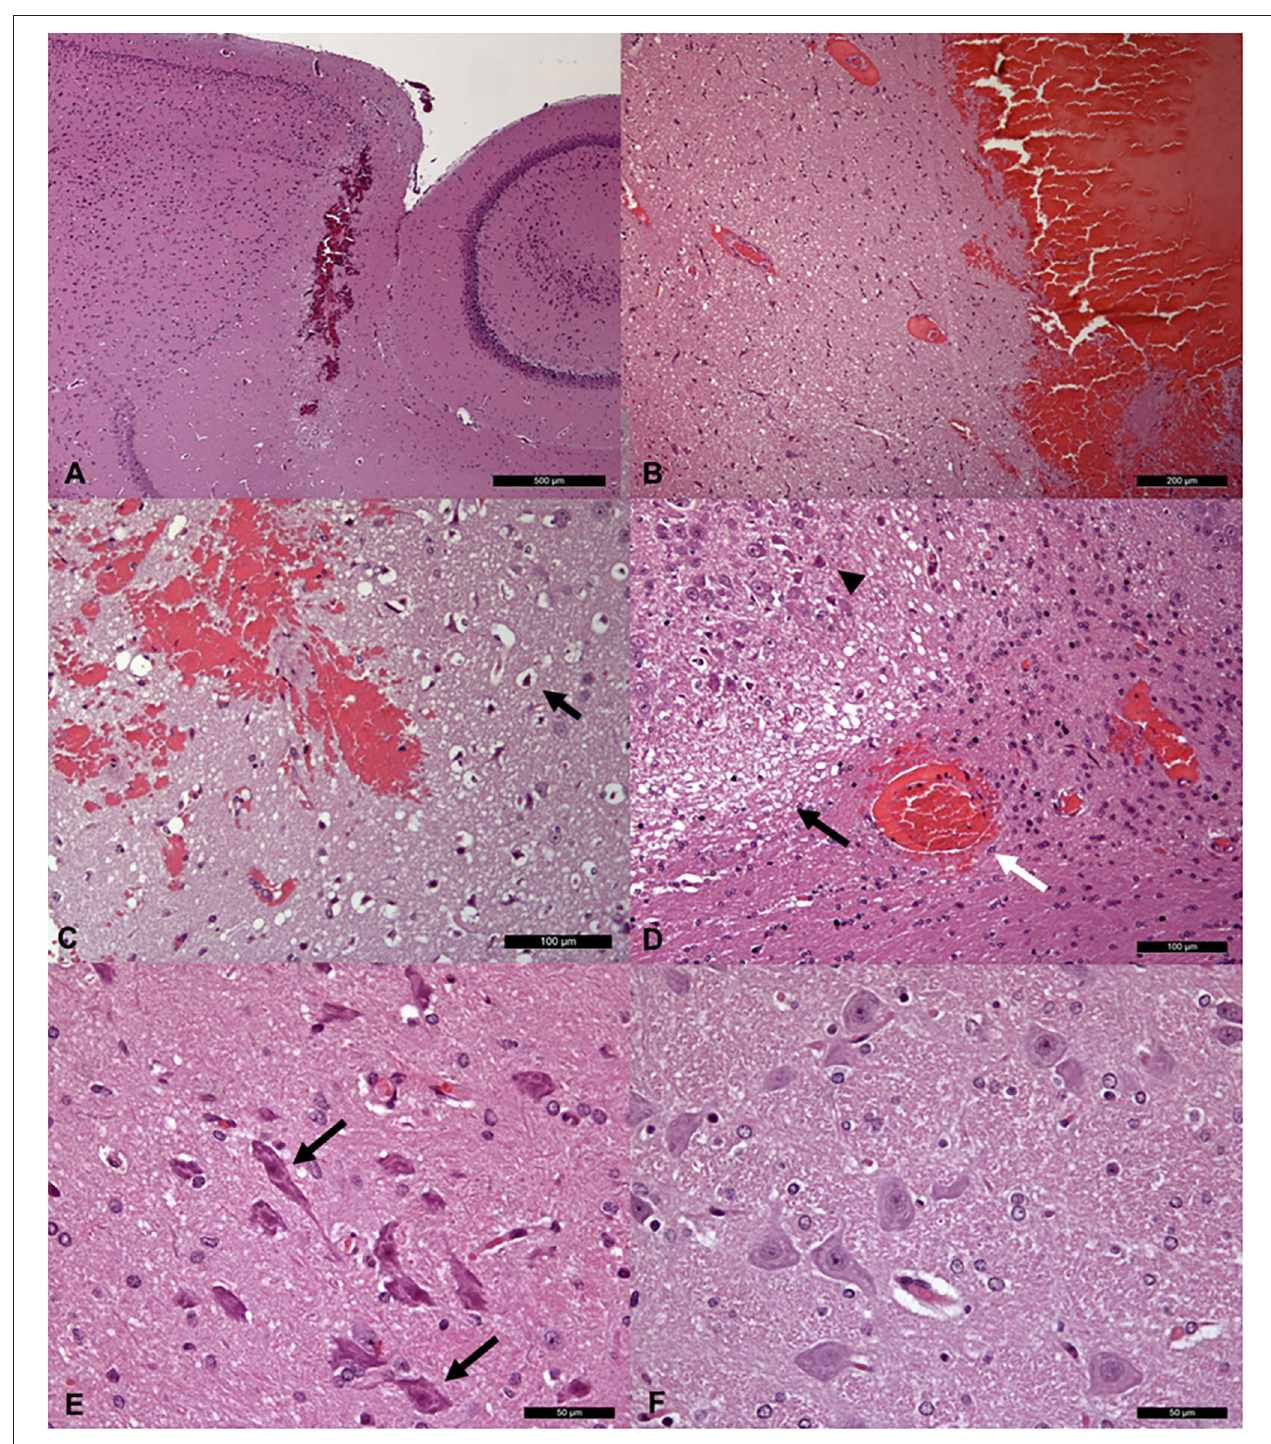
FIGURE 6 | Histopathological sections (A,B) Low (A) and high (B) magnification of brain sections passing through the needle path, showing a linear hemorrhagic area. (C,D) Histological images of peri- hemorrhage neural tissue, showing variably intense, (C) gray (perinuclear halos; arrow), and (D) white matter edema (black arrow) and multifocal neuronal shrinkage (arrowhead). Red blood cells within the wall of a small vessel are also visible (white arrow). (E) Higher magnification of multifocal neuronal shrinkage (arrows) in peri-hemorrhagic tissue. (F) Histologically normal neurons in the contralateral area of the unaffected cerebral hemisphere.